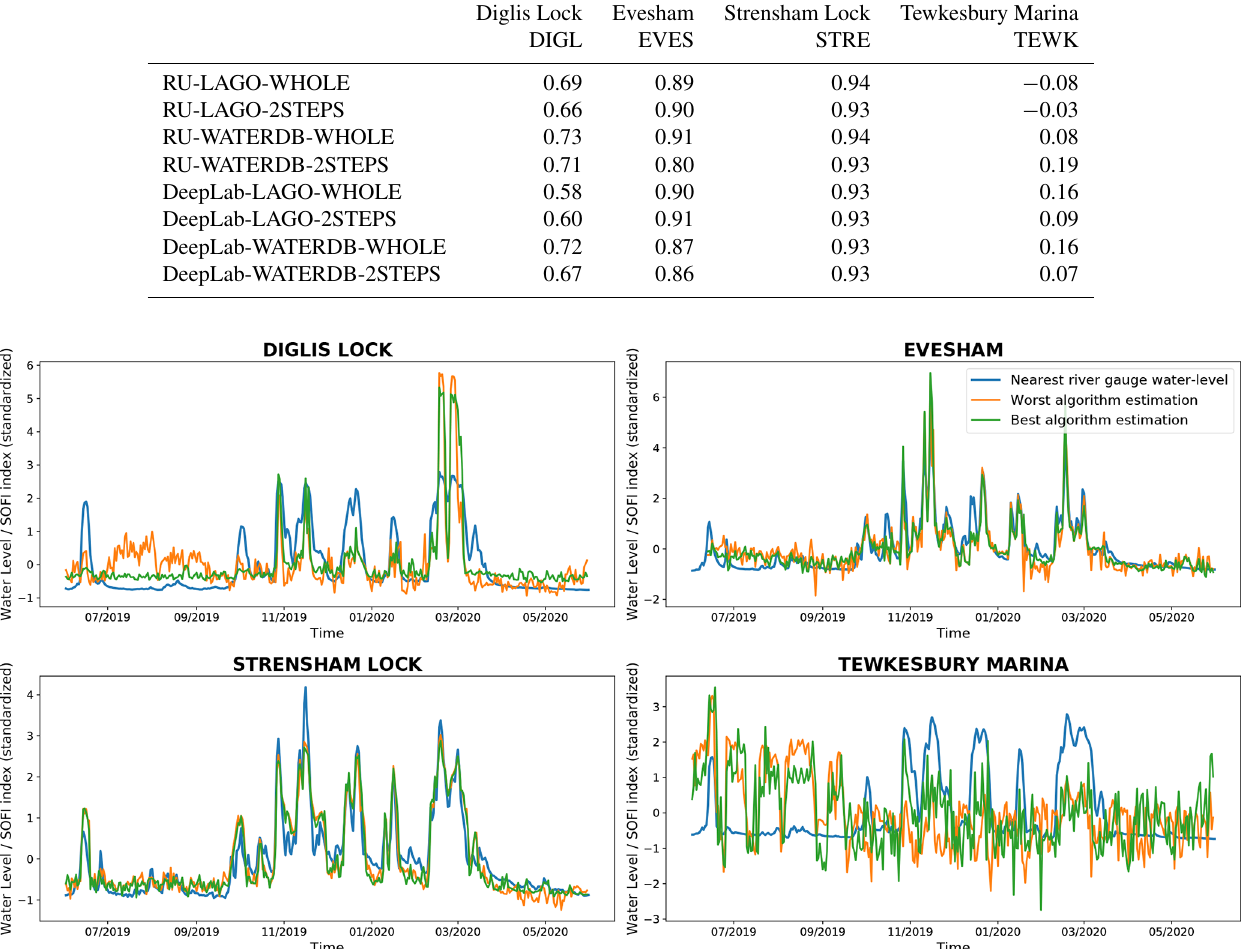
Figure 9. Standardised SOFIs in comparison with standardised water levels from nearby river gauges. For each location, the best and worst algorithms can be found in Table